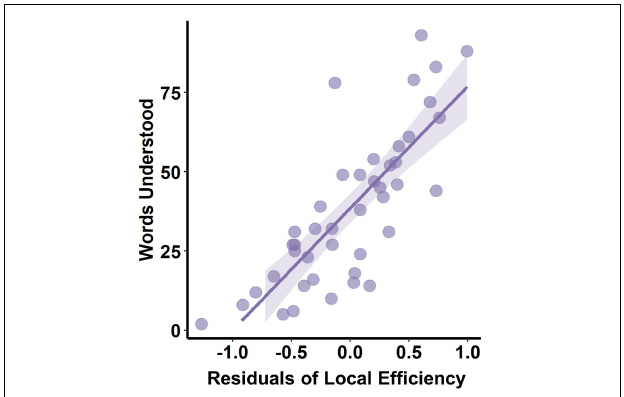
FIGURE 5 | Correlation between PMA-corrected local efficiency and words understood at 10